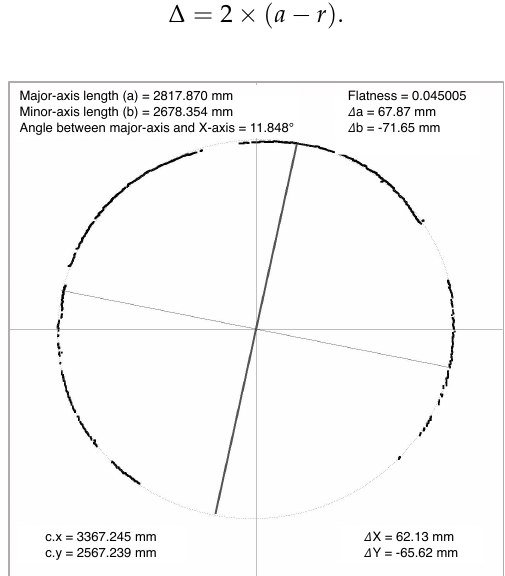
Figure 16. Identified cross-sectional deformation in metro tunnel.